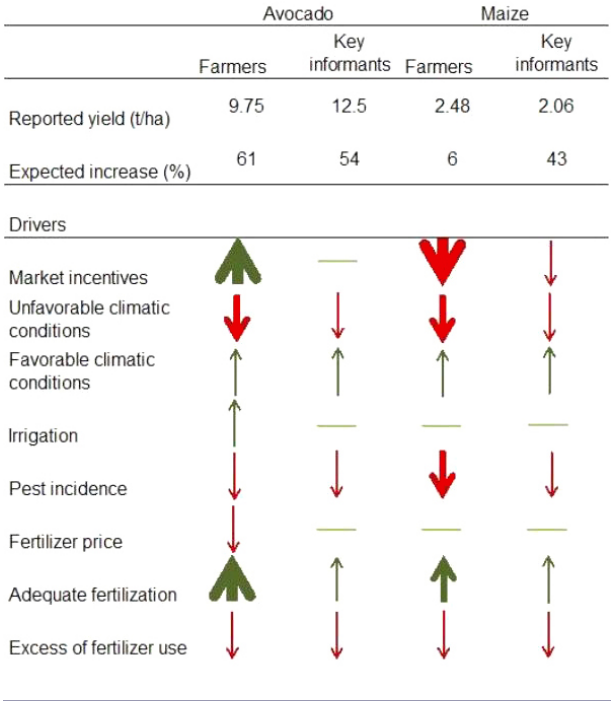
Fig. 6. Perceived drivers underpinning yield in maize and avocado agroecosystems. Arrow width reflects frequency of responses (smallest to widest: zero [dash], ≤ 30%, 30–50%, ≥ 50%). Green = positive association, red = negative